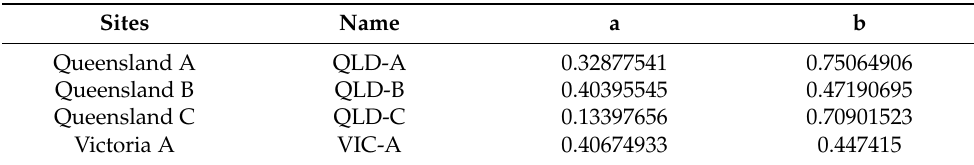
Table 3. Coefficients relating cloud index to clear sky